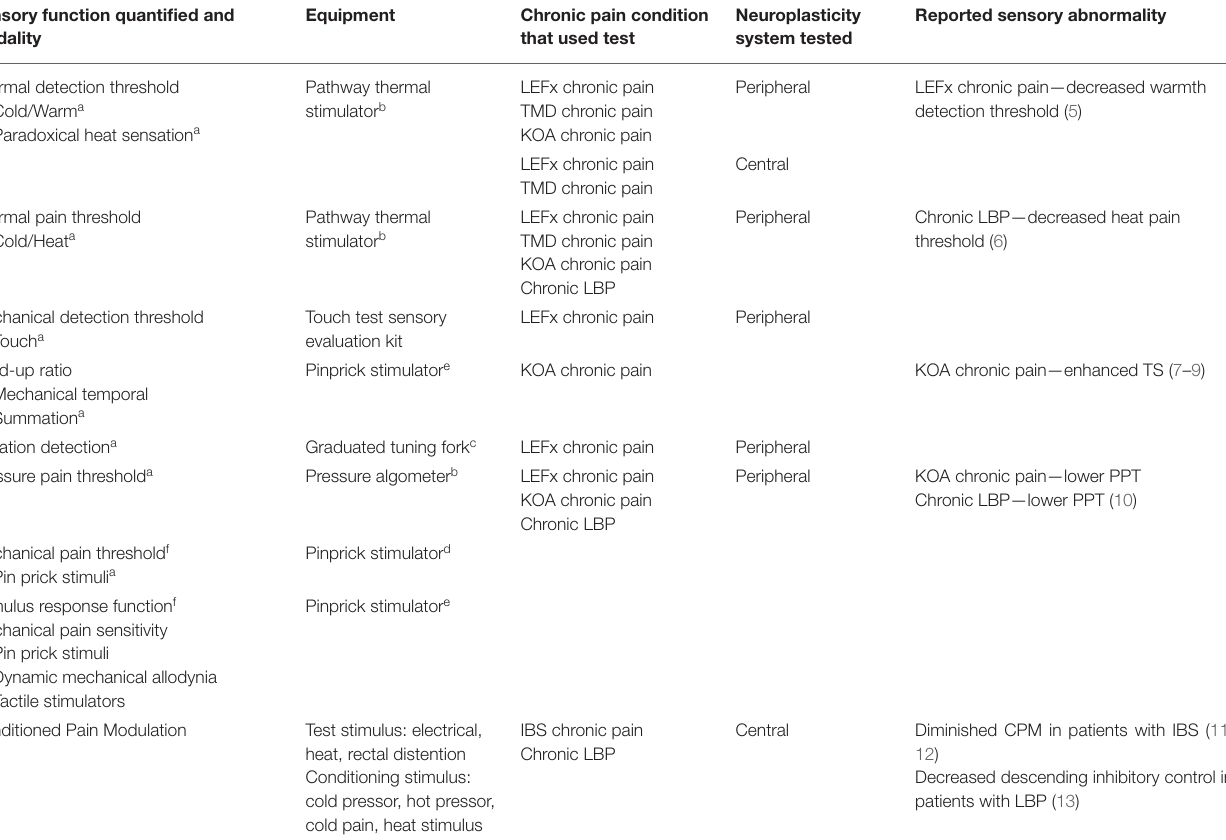
TABLE 1 | Specific tests from the German Research Network on Neuropathic Pain QST protocol by chronic pain conditions of interest and Conditioned Pain Modulation. Sensory function quantified and